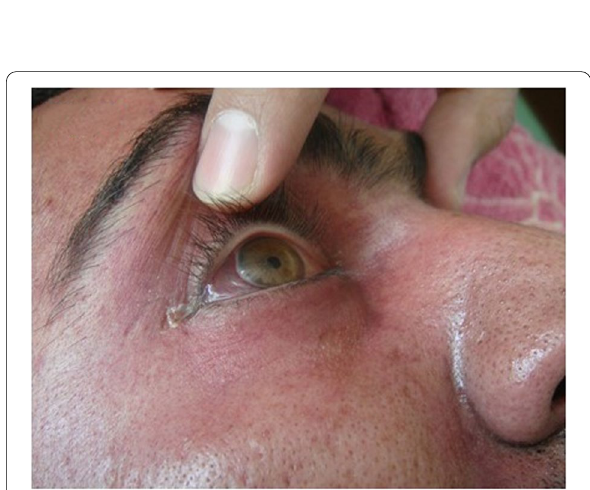
Fig. 8 A close view of case 2 showing the discoloration of the face and sub-conjunctival hemorrhage